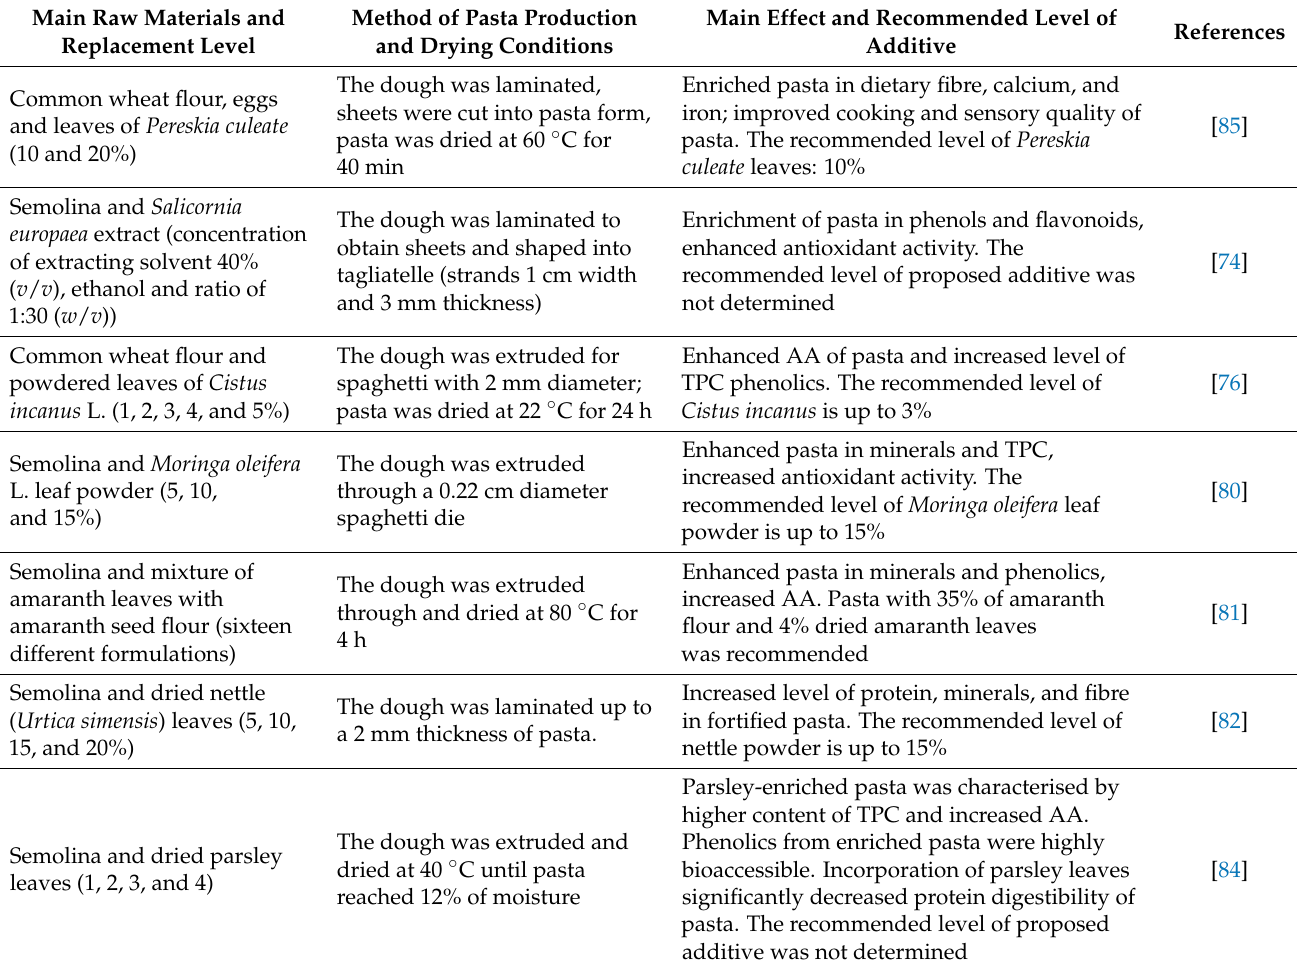
Table 4. Influence of addition of herbs and different parts of plants on wheat pasta